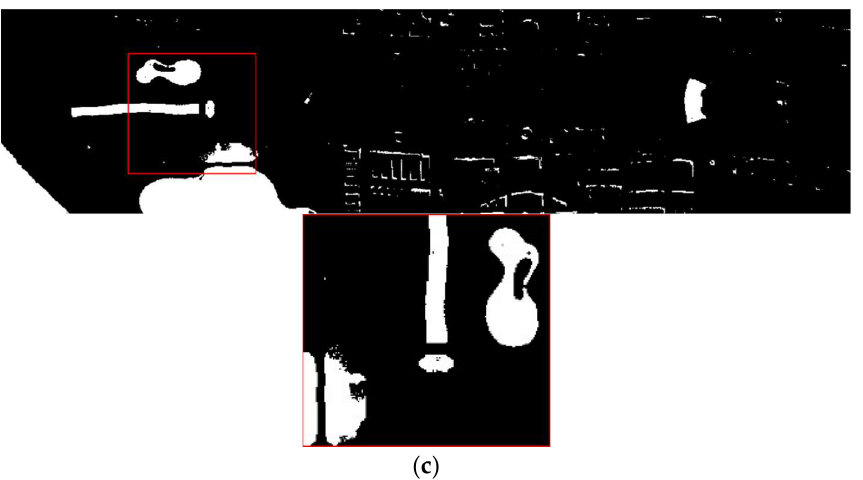
Figure 7. Extraction results of water body and partial enlarged image: ( a ) Ground truth information; ( b ) NDWI extraction result; ( c ) BAND9 extraction result.